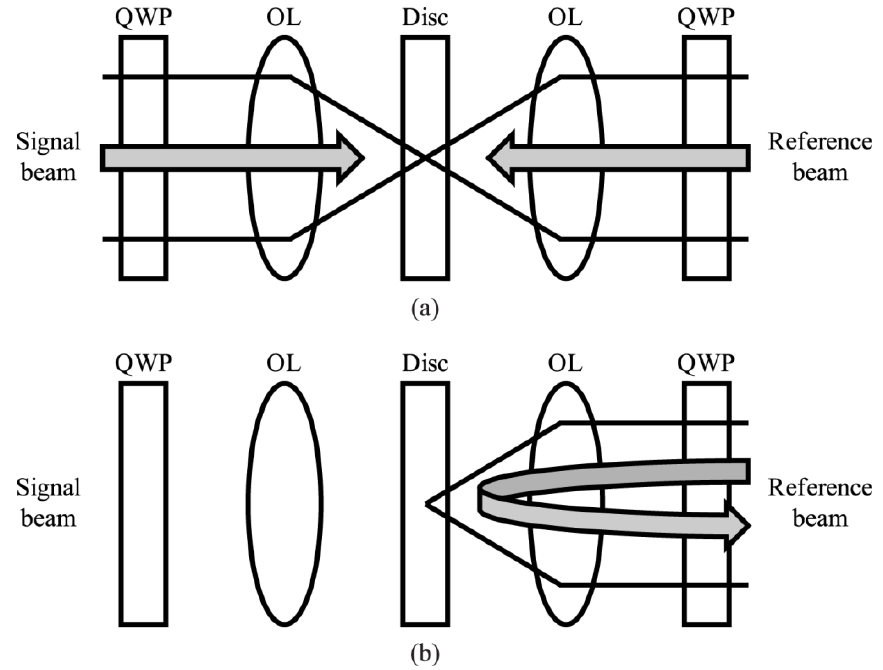
Figure 1. Recording and reading principles of micro holographic storage system (MHSS): ( a ) recording and ( b ) reading. The recording and reading beams propagate along the z -axis. The incident beam is circular polarized light.